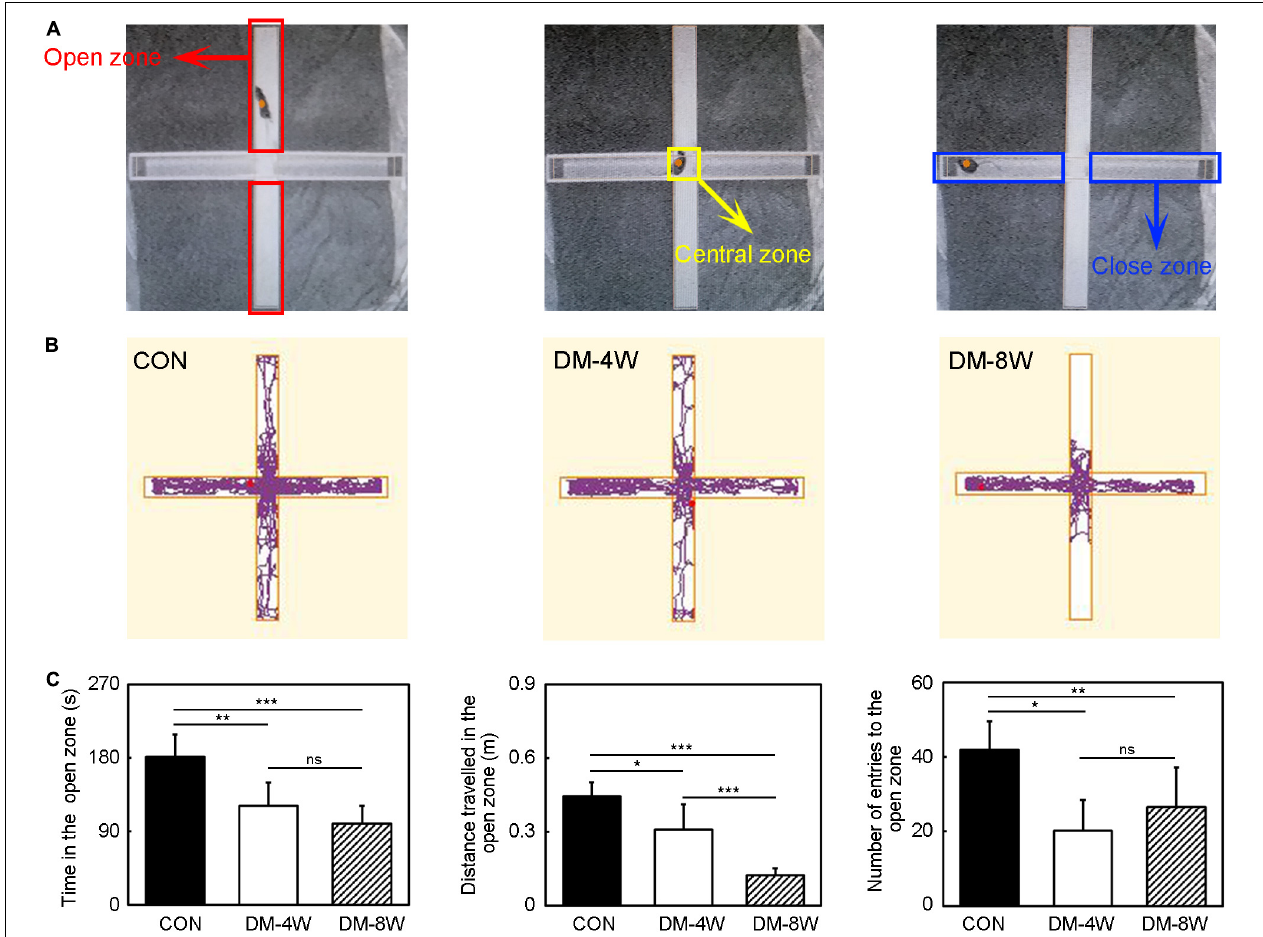
FIGURE 4 | Anxiety behavior increased in diabetic mice. (A) The diagram of the elevated plus maze zone. The red box indicates the open zone. The yellow box indicates the central zone. The blue box indicates the close zone. (B) The track plot showed the mouse trace of the control, DM-4W and DM-8W groups in the elevated plus maze. (C) Bar graphs showed the time in the open zone, the distance traveled in the open zone and number of entries to the open zone. Data are mean ± SD , n = 8 per group, * p < 0.05, ** p < 0.01, *** p < 0.001.